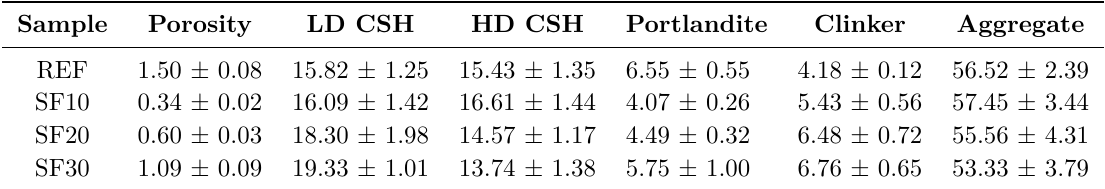
(c) . SF20 BSE diagram (left) image analyses (right). (d) . SF30 BSE diagram (left) image analyses (right). Figure 2. Example of matrix analysis: white=clinker, red=CH, magenta=HD CSH, green=LD CSH, blue=pores. Sample